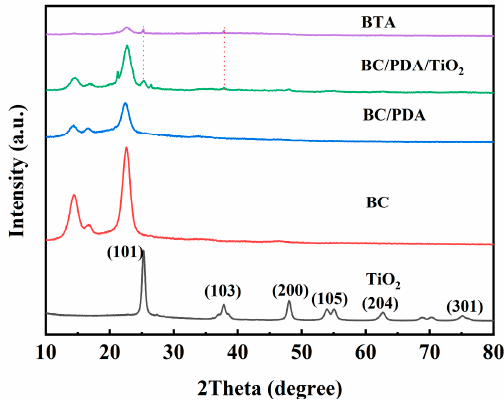
Figure 4. XRD images of four different load membranes.